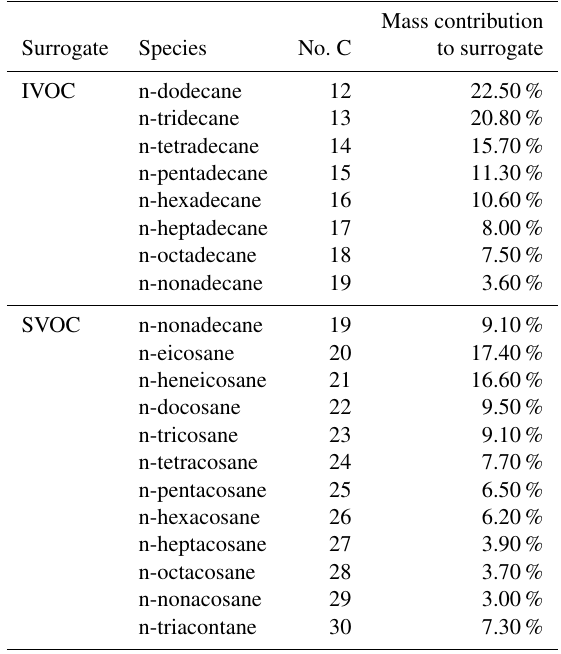
Table 3. Chemical speciation of the considered SVOC and IVOC mixtures in GECKO-A (Lee-Taylor et al.,